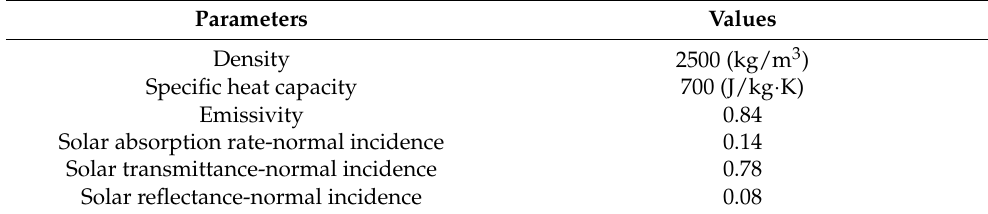
Table 4. Parameters of glass window.